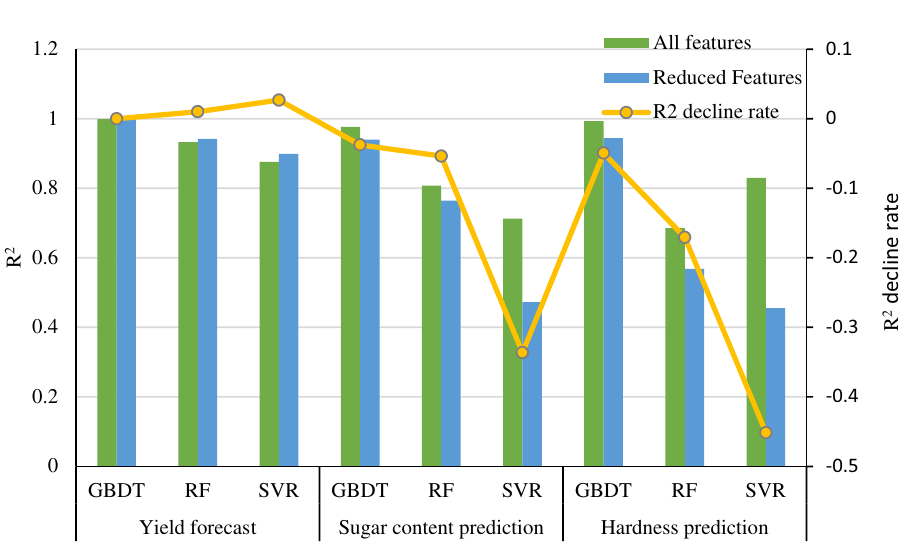
Figure 6. Comparison of R 2 indicators for different models before and after feature